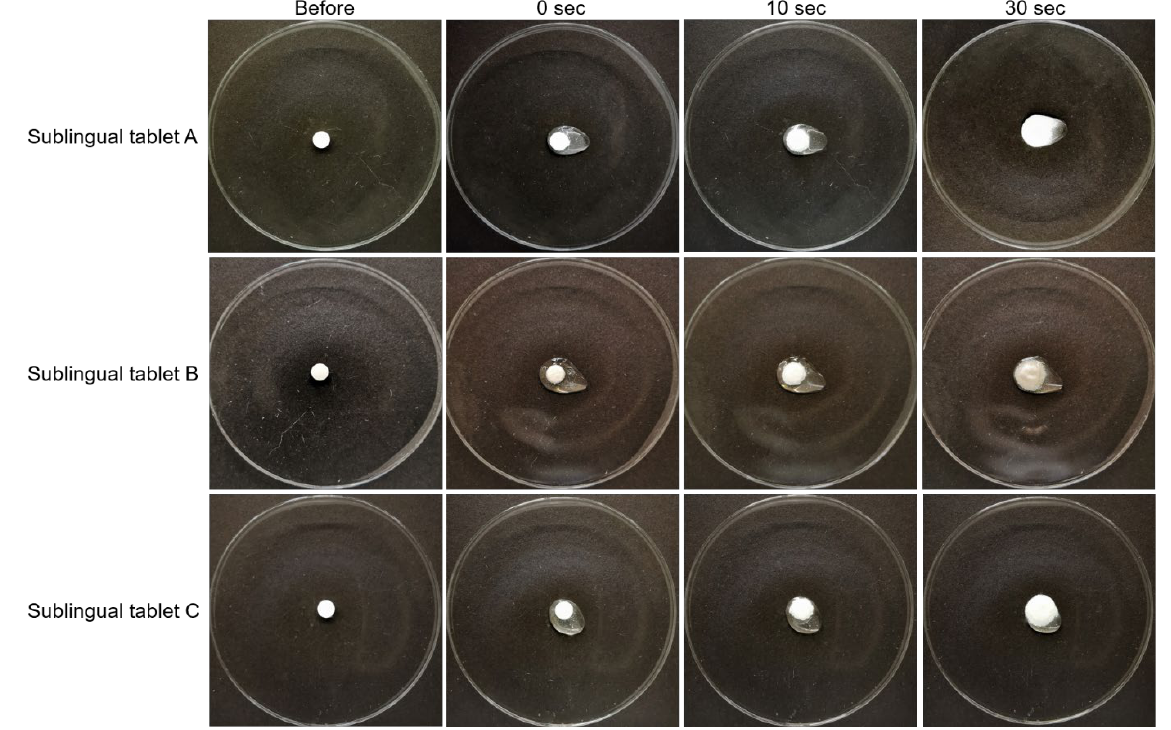
Figure A1. Disintegration of cyclobenzaprine sublingual tablets after addition of 150 µL freshly collected human saliva in dependence on time.